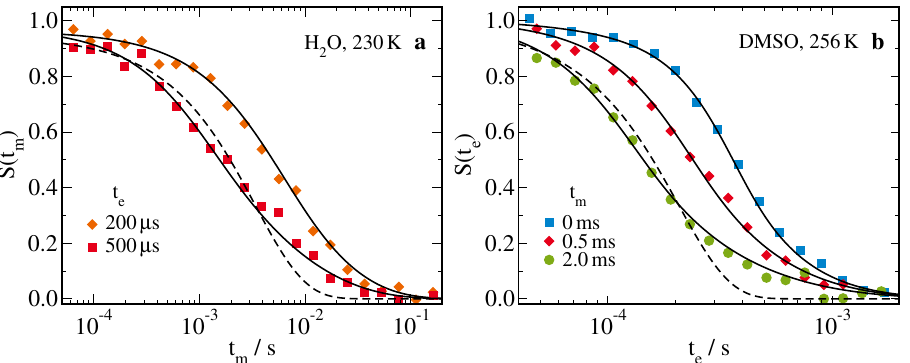
Figure 9. 1 H SFG STE decays of aqueous DMSO solutions in silica pores with a diameter of d = 2.8nm: ( a ) S ( t m ) of 66mol% H 2 O-DMSO- d 6 for the indicated evolution times t e at 230K and ( b ) S ( t e ) of 66mol% D 2 O-DMSO- h 6 for various mixing times t m at 256K, where data obtained from SFG Hahn-echo experiments are denoted as t m = 0. The solid lines indicate the results of global fits using the model of one-dimensional diffusion, see Equation (11). The dashed lines show fit results for the model of free diffusion, see Equation (10). They are included to indicate that the free-diffusion model fails to describe the NMR diffusion data for the silica